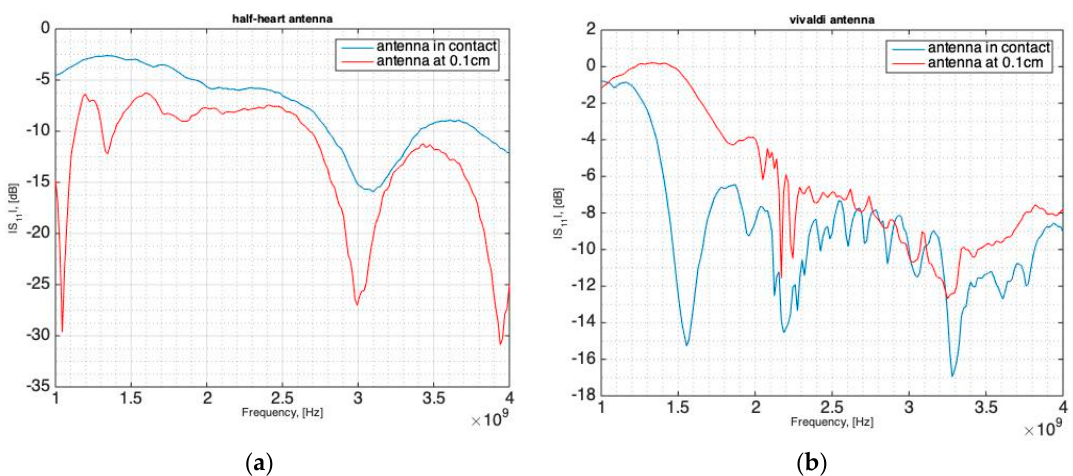
Figure A1. Amplitude of the S 11 scattering parameters as measured for the antenna in the central position (in correspondence of the applicator): ( a ) Half-heart antenna. ( b ) Vivaldi antenna.